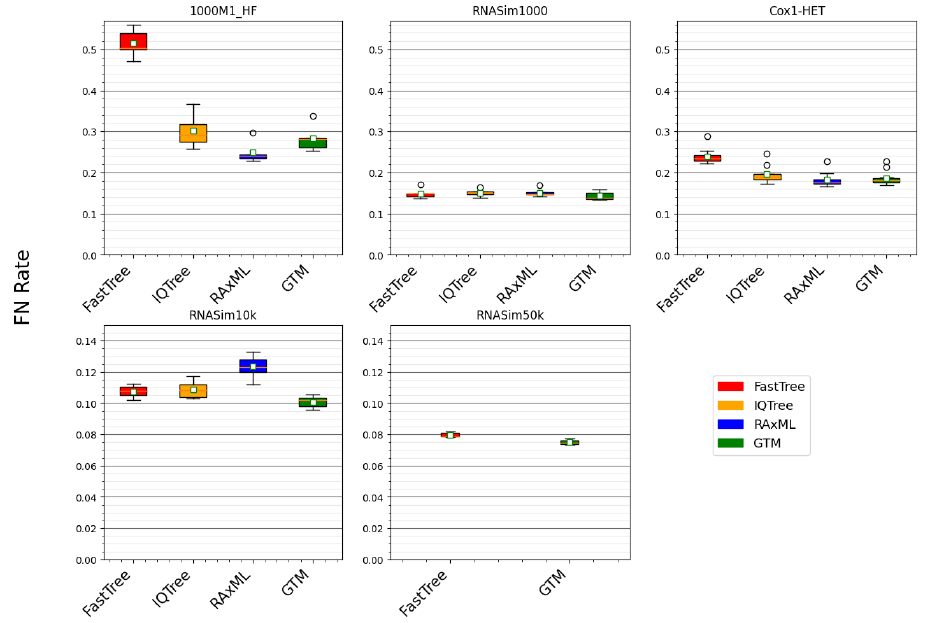
Figure 2. Comparing GTM pipeline to ML methods for error rates. Error rates for trees computed using standard ML methods and a GTM pipeline, combining IQ-TREE constraint trees. The starting tree is IQ-TREE for the smaller datasets (i.e., 1000M1-HF, RNASim1000, and Cox1-HET) and FastTree on the larger datasets (i.e., RNASim10k and RNASim50k). All of the ML methods were given true alignments and allowed to run to completion, except for RAxML, which was limited to 24 h on the 1000M1-HF, RNASim1000, and Cox1-HET datasets and limited to 168 h on the RNASim10k and RNASim50k datasets. On the RNASim50k datasets, IQ-TREE failed to return a tree and RAxML returned a tree with an error rate of 100%, and so the results for RAxML and IQ-TREE are not shown for that